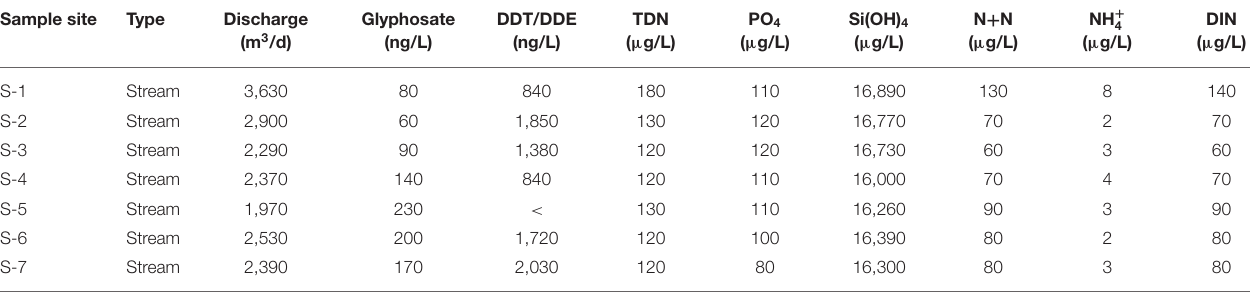
TABLE 2 | Stream discharge measurements and surface sample nutrient and pesticide concentrations. Sample site